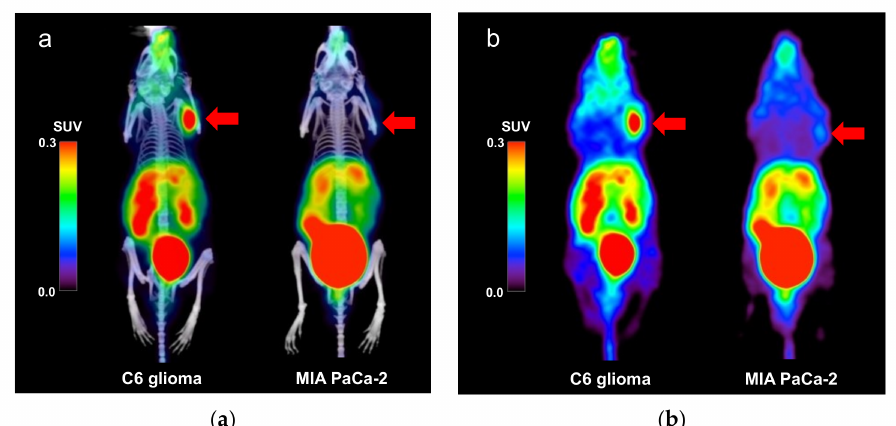
Figure 1. ( a ) Positron emission tomography (PET)/computed tomography (CT) and ( b ) PET images (maximum intensity projection) showing the uptake of the [ 68 Ga]Ga-DOTA-c(RGDfK) peptide in the C6 glioma and MIA PaCa-2 model mice. The arrows indicate the locations of the tumor xenografts. Abbreviations: DOTA, 1,4,7,10-tetraazacyclododecane-1,4,7,10- tetraacetic acid; RGD, Arg-Gly-Asp.